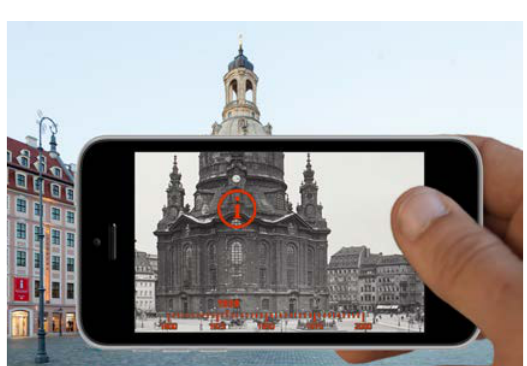
Figure 2. Augmented-reality representation of a cityscape